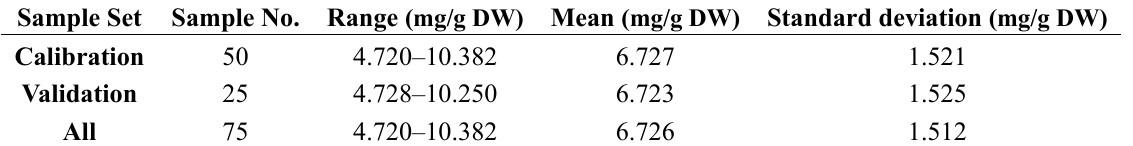
Table 1. Statistics of TAA in calibration and validation sets.